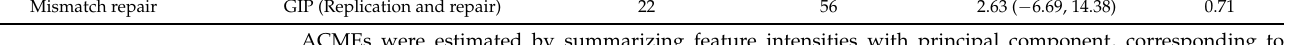
Table 4. Cont. p,p’ -DDE Mismatch repair GIP (Replication and repair) 22 56